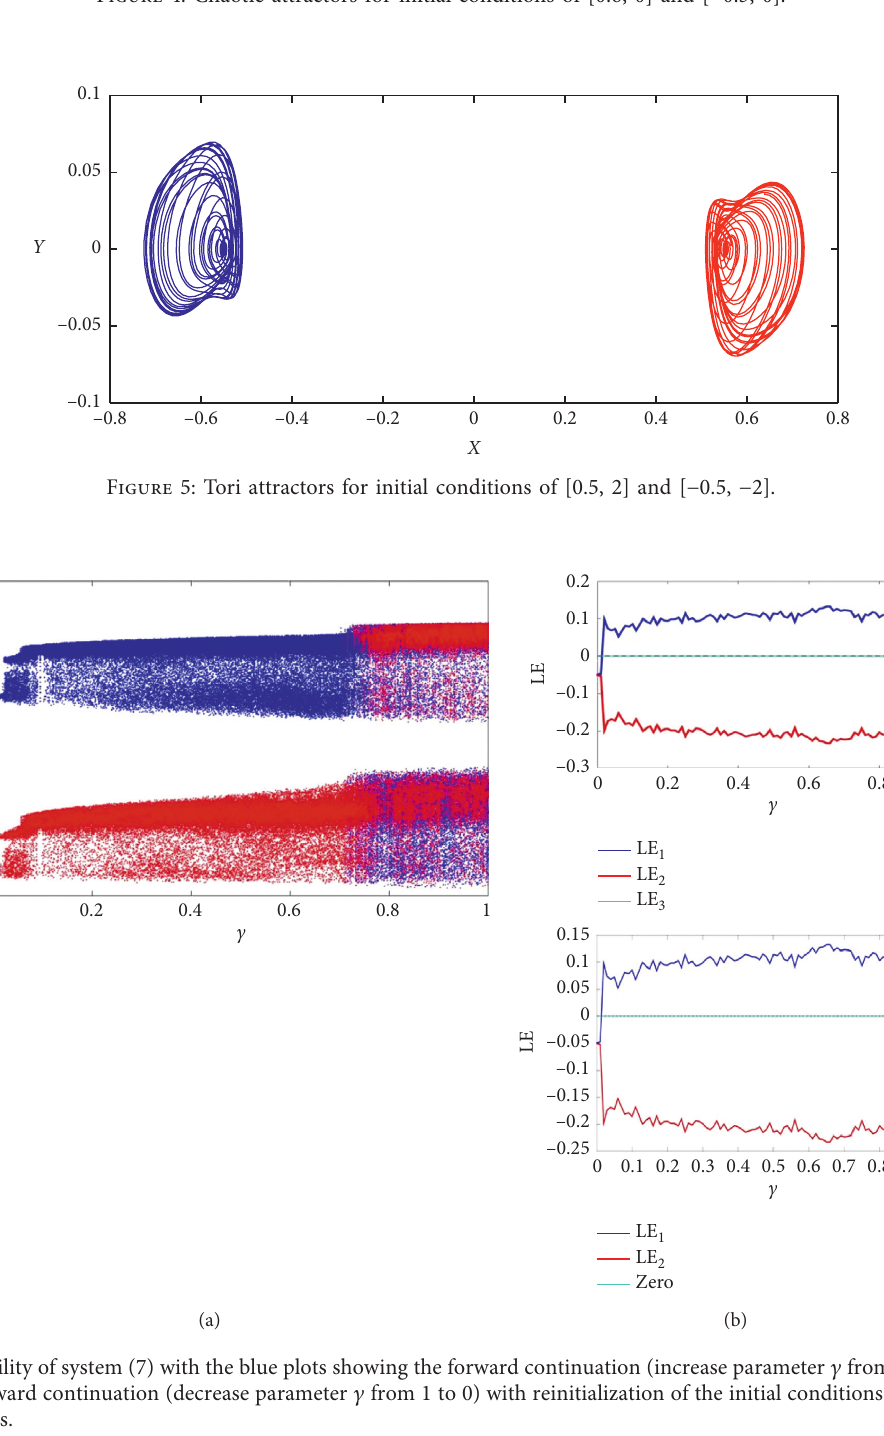
Figure 4: Chaotic attractors for initial conditions of [0.6, 0] and [ − 0.5, 0].